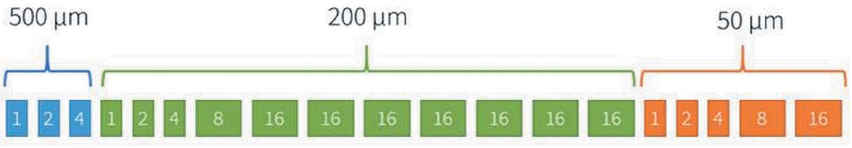
Figure 2 CRL transfocator layout at beamline 23ID-D. The numbers in the boxes show the number of lenses in each lens block and the numbers above indicate their radius of curvature. X-rays propagate from left to